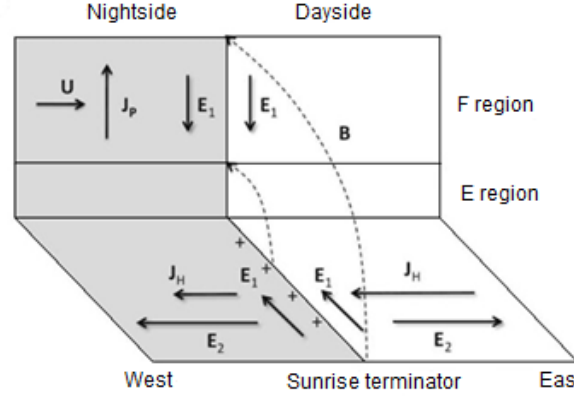
Figure 11. Sketch illustrating the processes responsible for the en- hancement of zonal electric fields around sunrise (partially modified from Farley et al., 1986; Kelley et al., 2014). Neutral thermospheric winds ( U ) moving eastward in the F region across the dawn ter- minator give rise to Pedersen currents ( J P ) in the F region, which create the polarization field ( E 1 ) that is mapped to the E region through the magnetic field lines ( B ). Hall currents ( J H ) through the terminator create an accumulation of positive charges along the ter- minator and a secondary electric field ( E 2 ) , directed to the east on the dayside and to the west on the